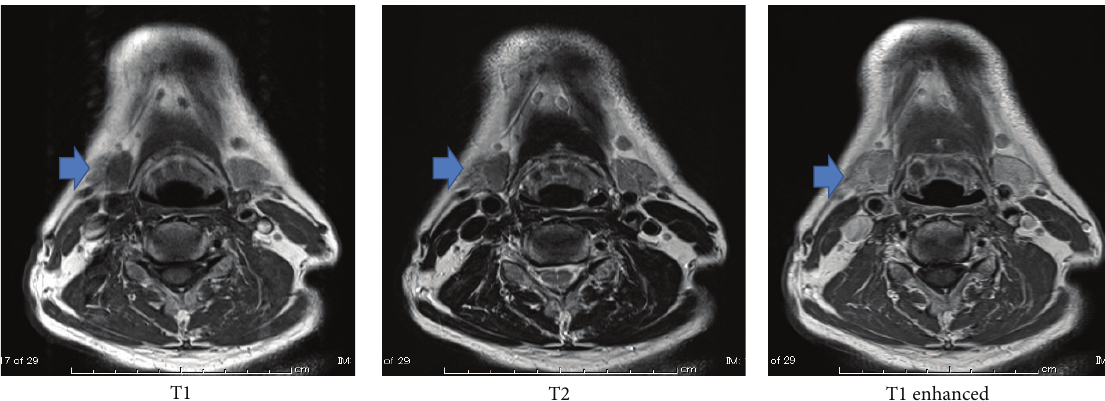
T1 T2 T1 enhanced Figure 2: Neck MRI showing 20 mm × 10mm tumor with an indistinct boundary and slight enhancement in the right submandibular gland. Signal intensities are low on both T1- and T2-weighted images.